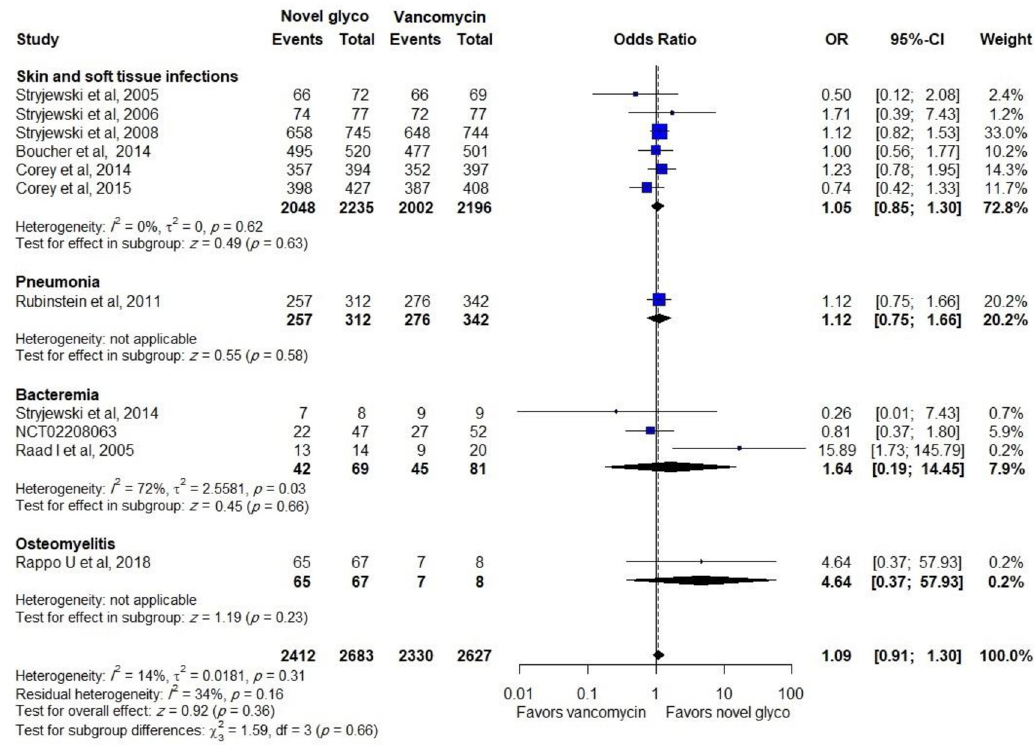
Fig 3. Clinical response of novel glycopeptides against vancomycin in the clinical evaluable populations.